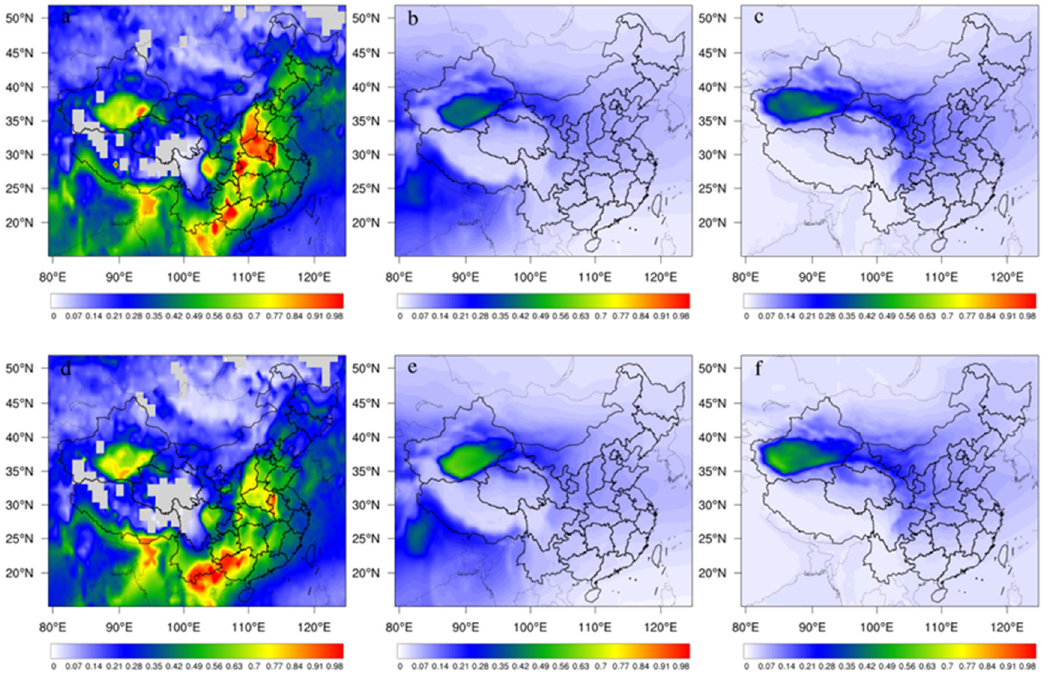
Figure 3. AOD maps of MODIS ( a ) 2015, MERRA2 ( b ), and WRF-Chem simulation ( c ) in 2015, and of MODIS ( d ), MERRA2 ( e ), and WRF-Chem ( f ) simulation in 2019.